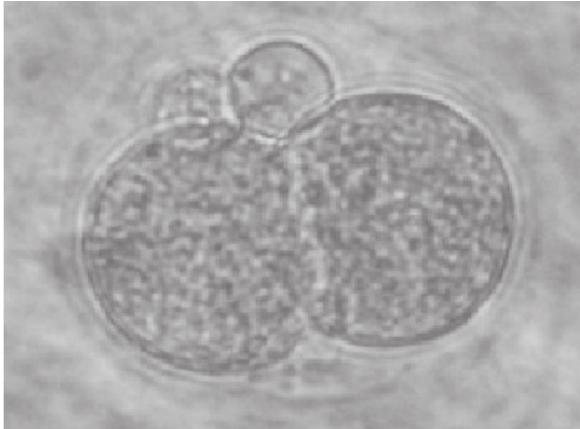
Figura 3. Embrião exposto aos ao extrato etanólico da casca de ), blastômeros simétricos, com citoplasma Punica granatum _(G 3 uniforme após 24 h de incubação. Presença dos dois corpúsculos polares na região apical da foto (100x, 5,7x zoom).